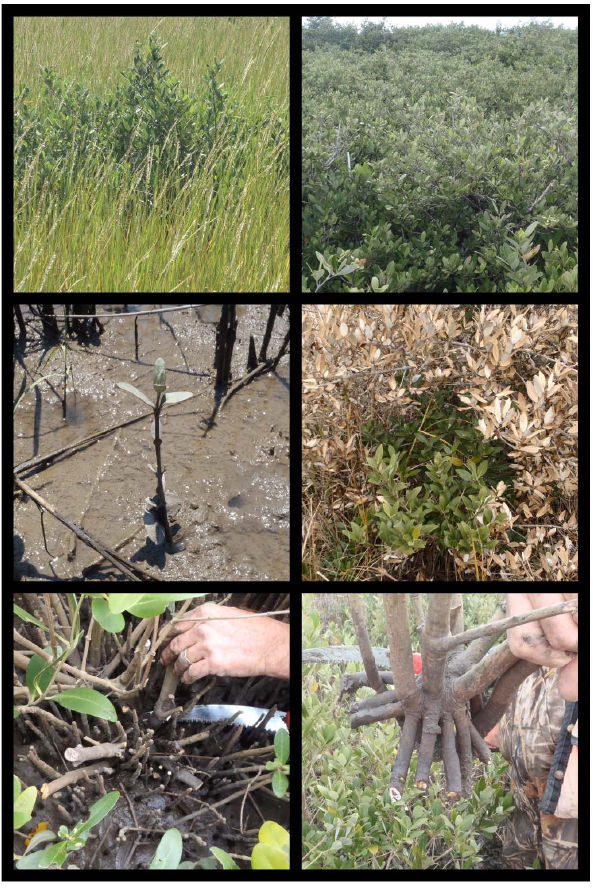
Figure 1. Photos of freeze-affected black mangroves ( Avicennia germinans ) in Louisiana (USA) near their northern range limit. The upper two photos show the shrub-like morphology. The middle left photo shows the size of the smallest individuals included in the analyses. The middle right photo shows leaf damage from an extreme winter temperature event in January, 2014. The lower two photos show the high stem density of freeze-affected individuals.